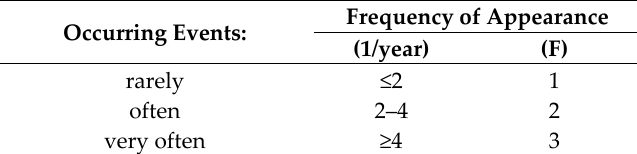
Table 1. Frequency of appearance